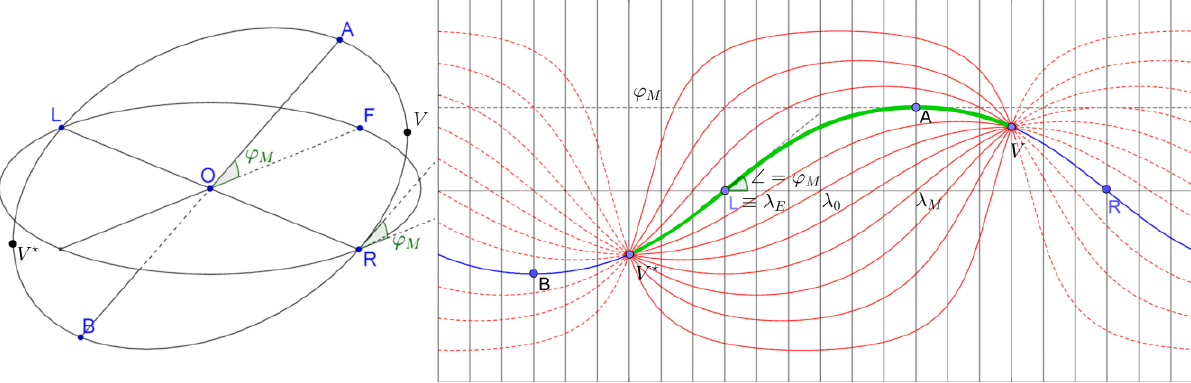
Figure 5 | Left: the plane of a great circle (𝜆 𝑀 ,𝜑 𝑀 ) = LARB. Right: the image of a set of parallels (red) and their great circles (dashed), with (𝜆 𝑀 ,𝜑 𝑀 ) in blue and green. Line 𝑉 ⋆ 𝐴𝑉 (green) has θ ≠ 0 but shares the plot of horizontal line 𝐿𝐴𝑅 = (𝜆 𝑀 ,𝜑 𝑀 ,0) , both being meridians of the same circle. The incline of the projected great circle equals 𝜑 𝑀 at 𝜆 𝐸